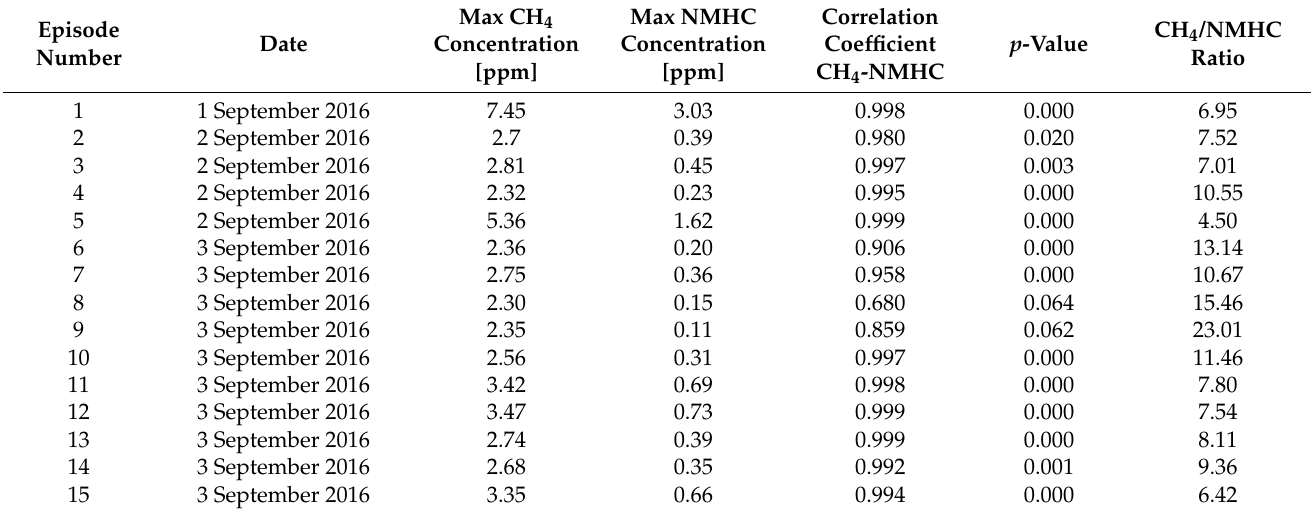
Table 5. Characteristic of CH 4 episode events observed for 1–4 September